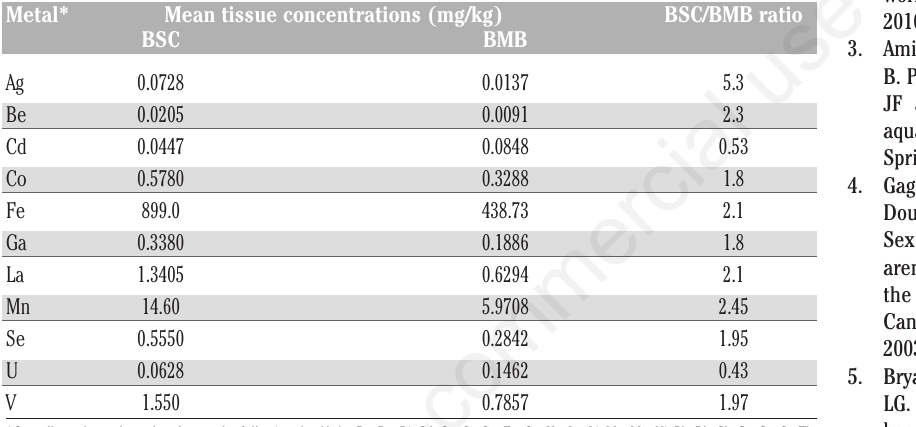
Table 1. Polychaete tissue levels for metals that proved significantly different (P<0.05) between the Baie Ste-Catherine and Baie du Moulin à Baude